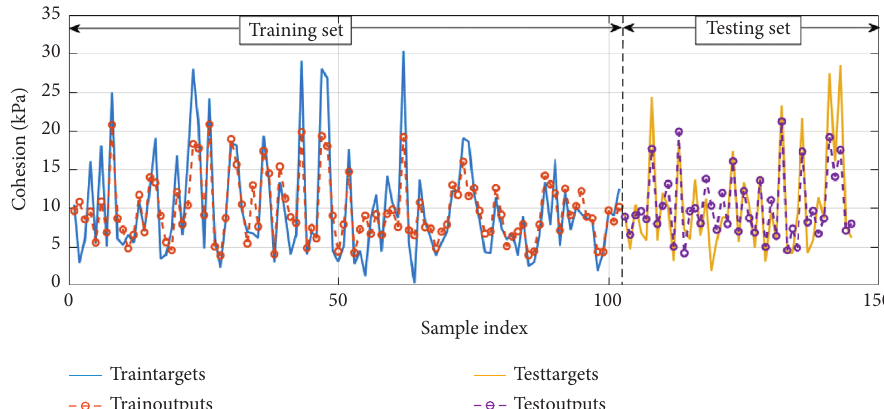
Figure 6: Comparisons of the training and testing datasets with the predicted and experimental values of soil cohesion.